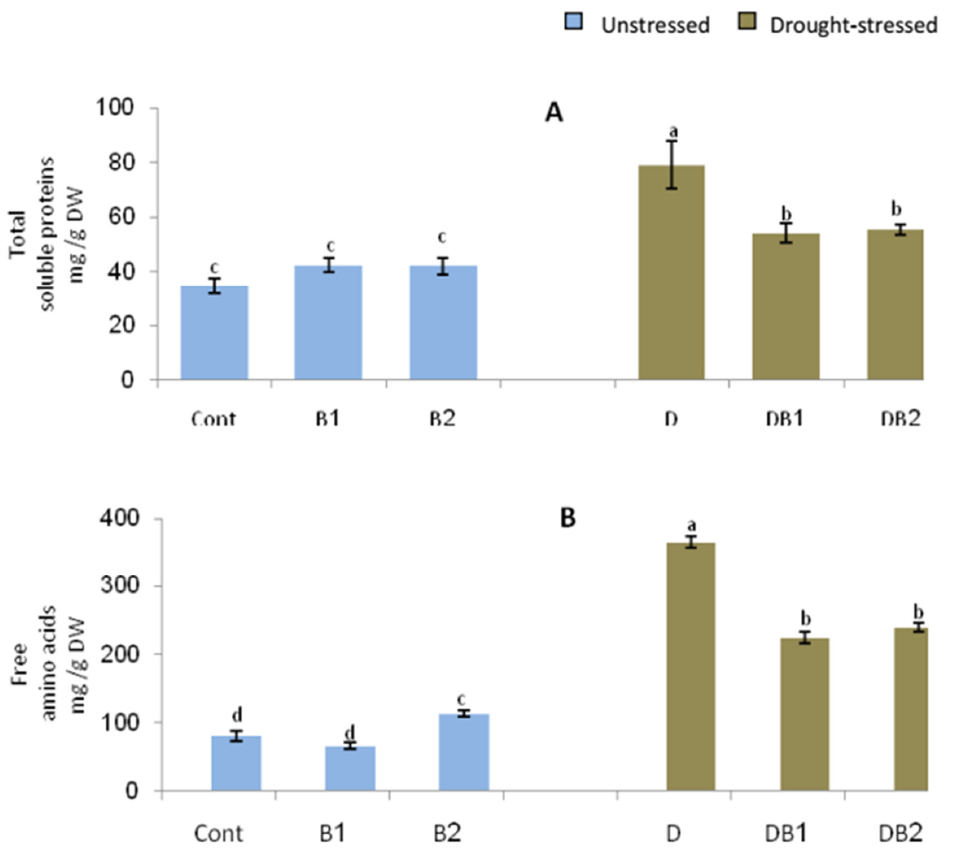
Figure 2. Effect of bacterial inoculation with A. brasilense NO40 (B 1 ) and S. maltophilia (B 2 ) on the contents of total soluble proteins (A) and total free amino acids (B) (mg/ g DM) of the yielded-grains of Triticum aestivum (cv. G9) plants grown in sandy soil, under unstressed (irrigated every 5 days) and drought-stressed (irrigated every 10 days) conditions. Error bars represent the standard deviation between 3 replicas. Treatments with identical letters are not significant at P ≤ 0.01. Cont. = the unstressed- uninoculated control; D= the drought-stressed-uninoculated treatment, B (1-2) = the